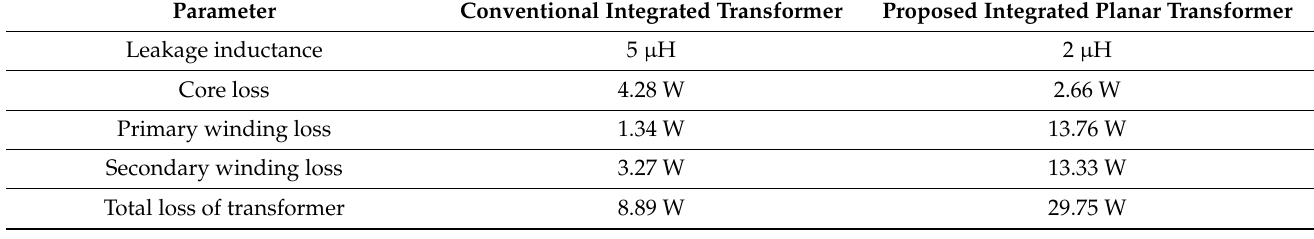
Figure 10. Planar transformer core and conduction loss simulation at 270 V input and full load con- ditions. Table 1. Design results of the integrated planar transformer. Table 1. Cont.